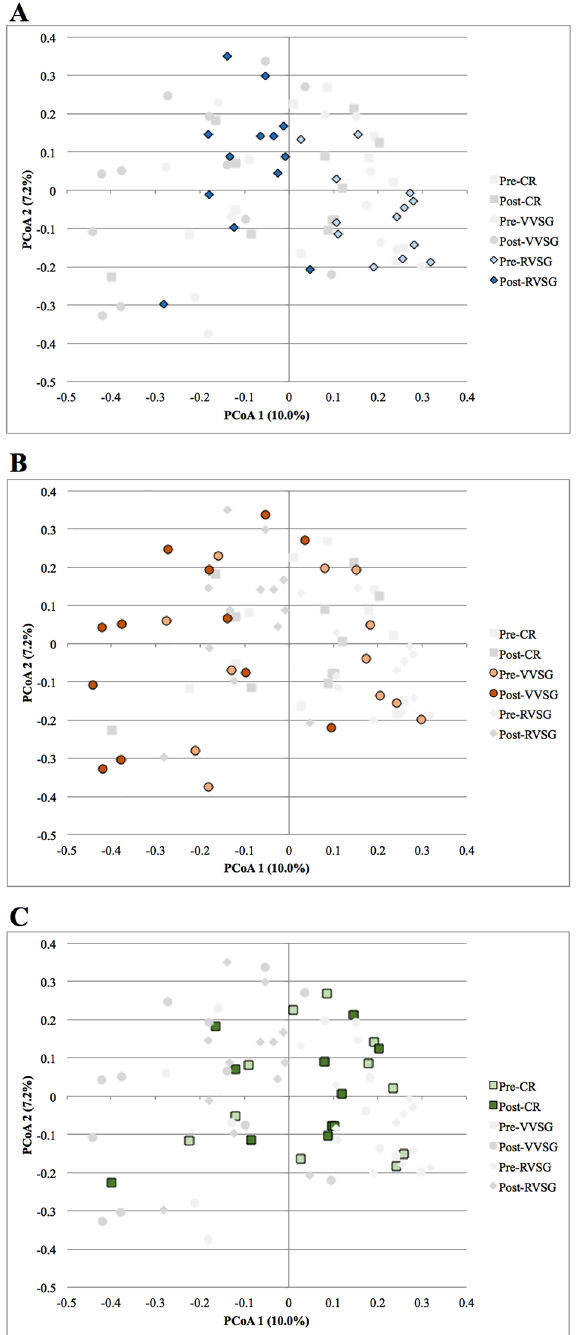
operative communities ( p <